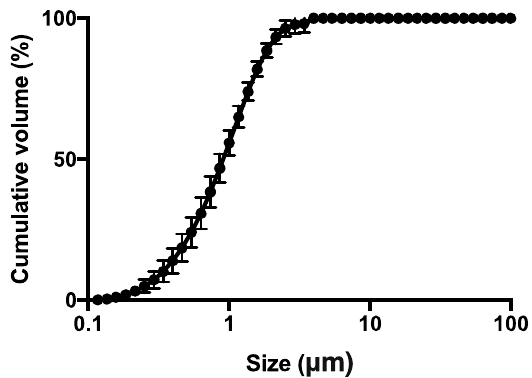
Figure 3. Particle size cumulative undersize distribution evaluated by laser light diffraction of the spray dried powder (square). The bars represent the standard deviation ( n = 3).